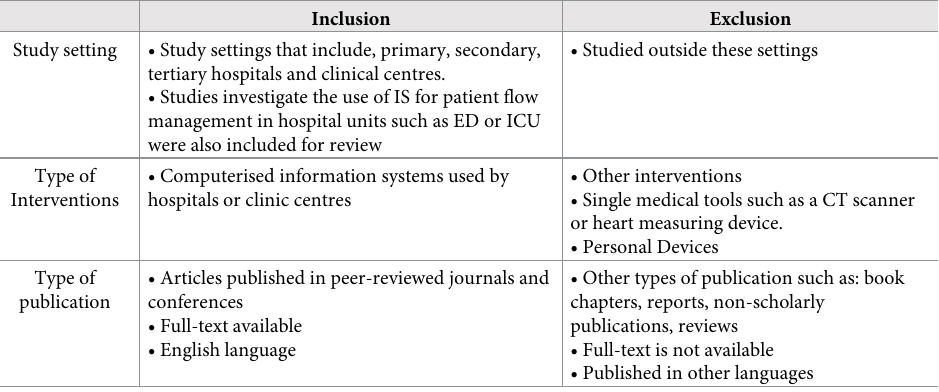
Table 2. Inclusion and exclusion criteria applied in the screening process.